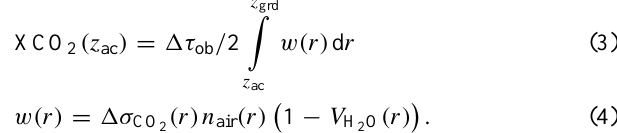
Table 1. Estimated 1τ and sensitivity of lower altitude CO 2 for the center and edge wavelength. Atmospheric parameters are based on the AFGL mid-latitude winter. Two CO 2 vertical pro- files (boundary-layer enhanced and constant along height) were as- sumed: for one, the CO 2 mixing ratio was constant at 385ppm along height; for the other, the mixing ratio was 410ppm from the ground to 0.5km, 398ppm from an altitude of 0.5 to 2km, and 385ppm at an altitude above 2km altitude,